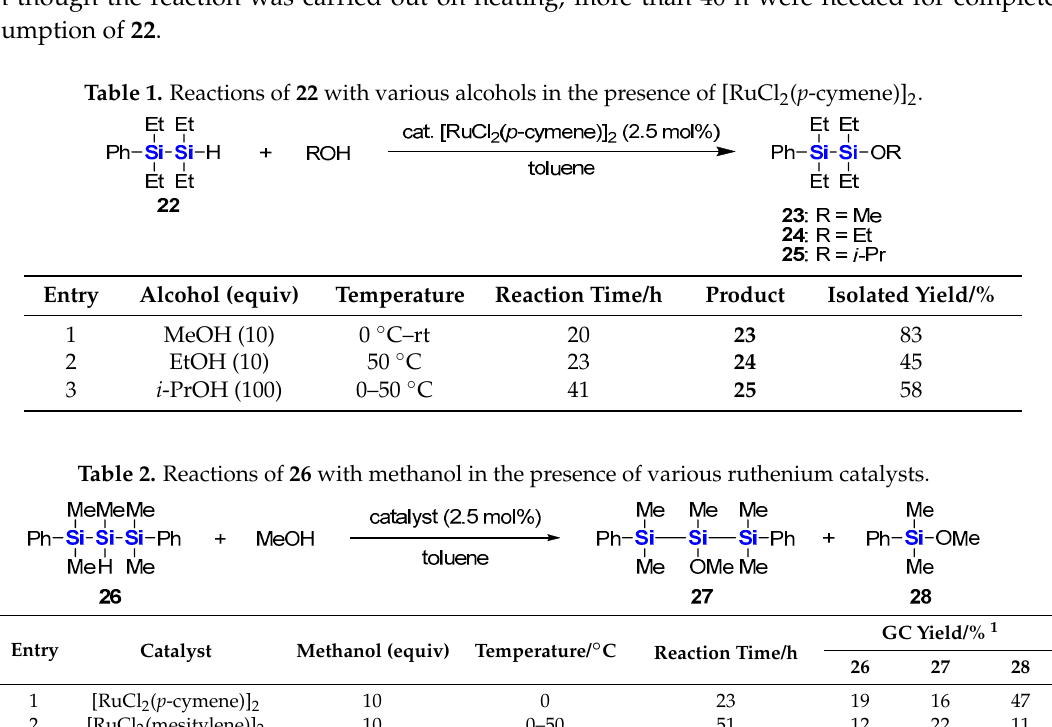
Table 1. Reactions of 22 with various alcohols in the presence of [RuCl 2 ( p -cymene)] 2 .